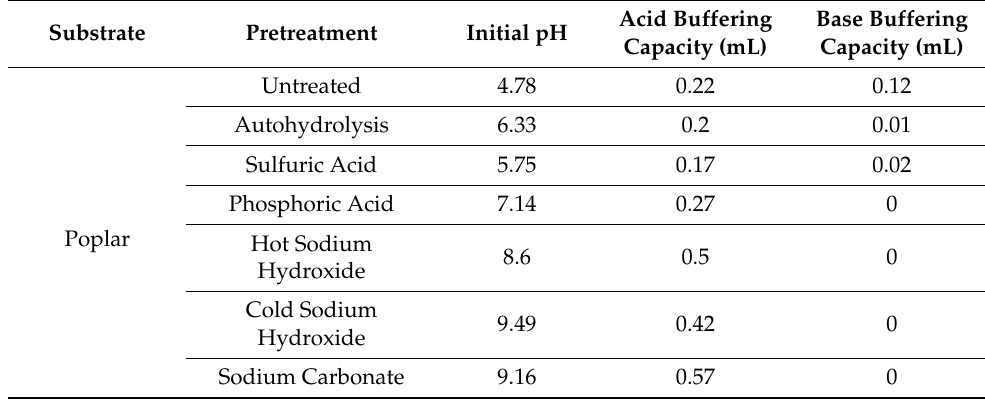
Table 3. Initial pH, acid buffering capacity, and base buffering capacity before and after pretreatment of poplar wood, pinewood, and rice